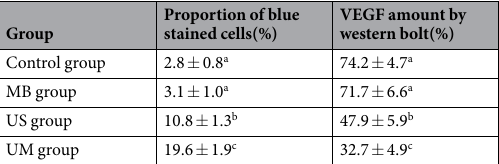
Table 2. Typan blue staining and western bolt result in each group. a Compared with US group and UM group, b compared with control group, MB group, and UM group, c compared with control group, MB group, and US group (P <